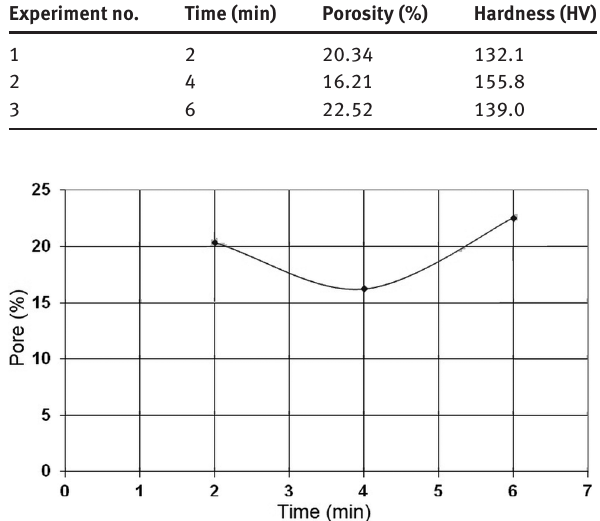
Fig. 8: Porosity ratios of the composites manufactured at 800 °C temperature and 500 rev/min stirring speed, with 6% reinforcement volume in 2, 4 and 6 minutes